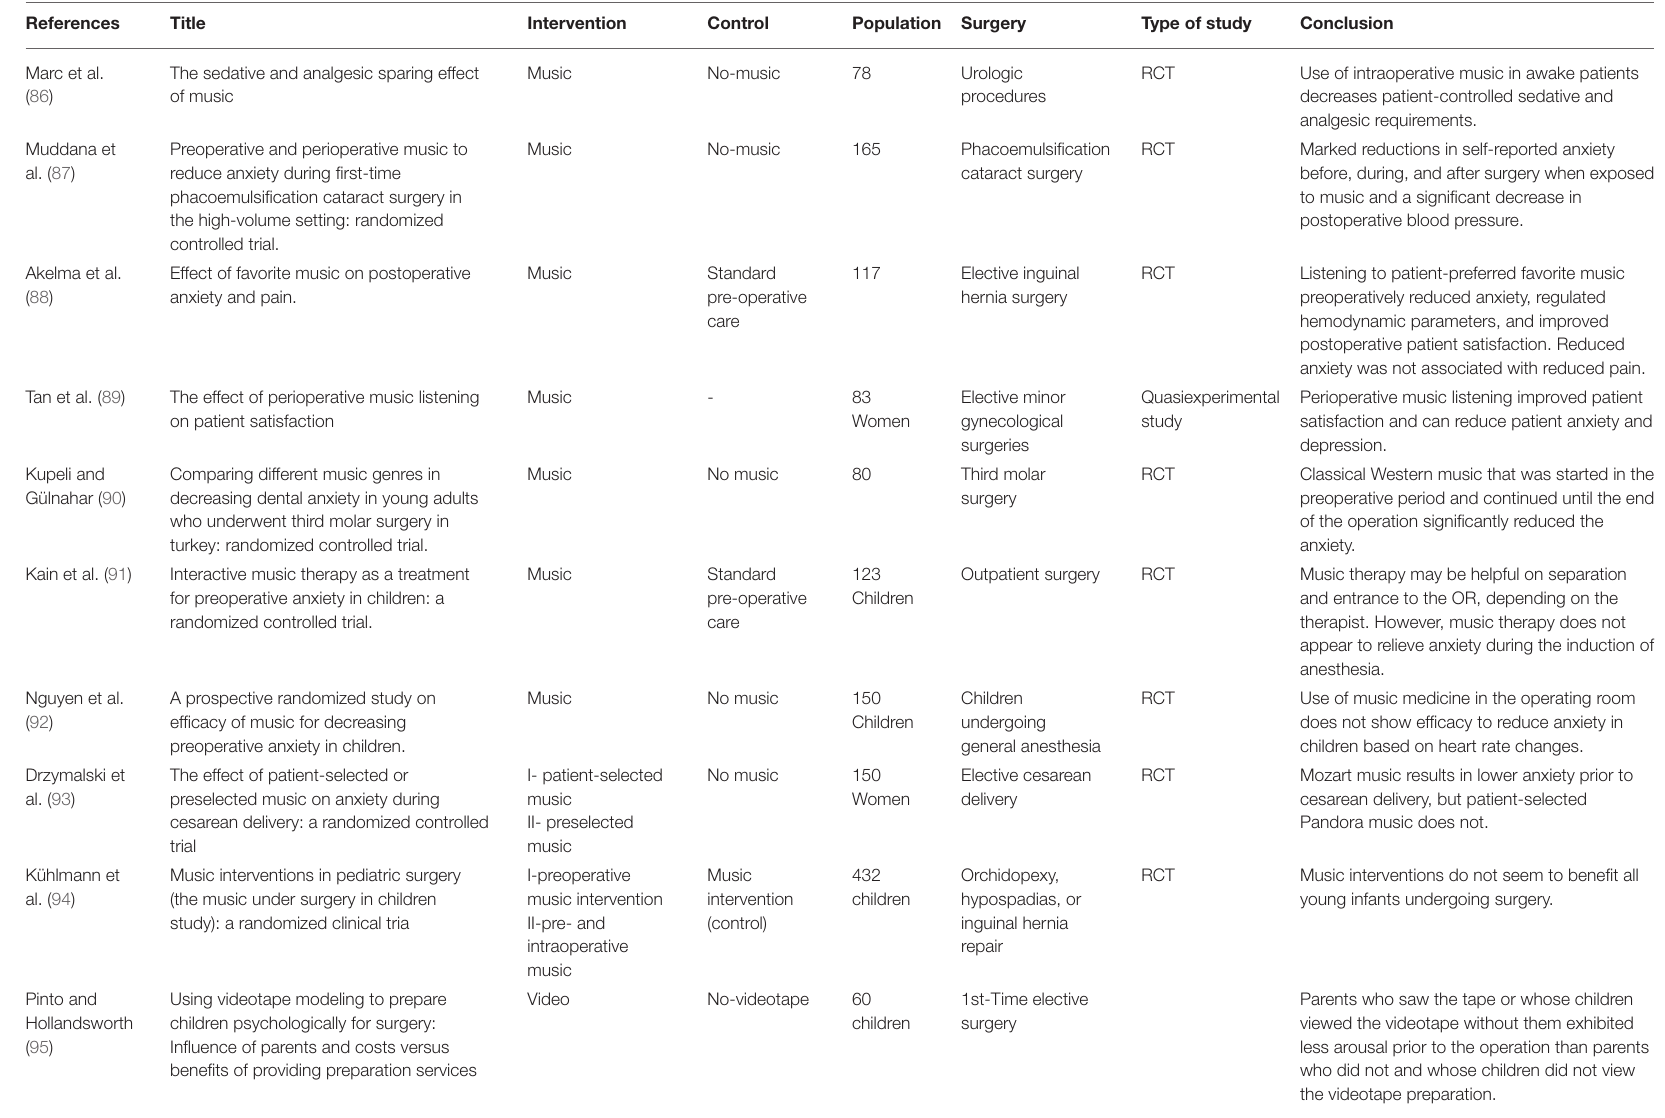
TABLE 2 | Clinical studies on the efficacy of preoperative music and video in preoperative